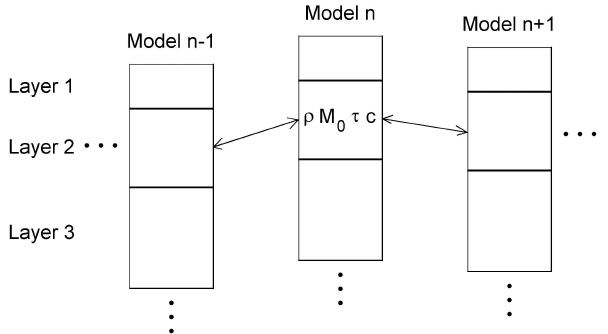
Fig. 5. Laterally constrained inversion (LCI) model set-up. The ar- rows represent the lateral constraints. From Fiandaca et al.